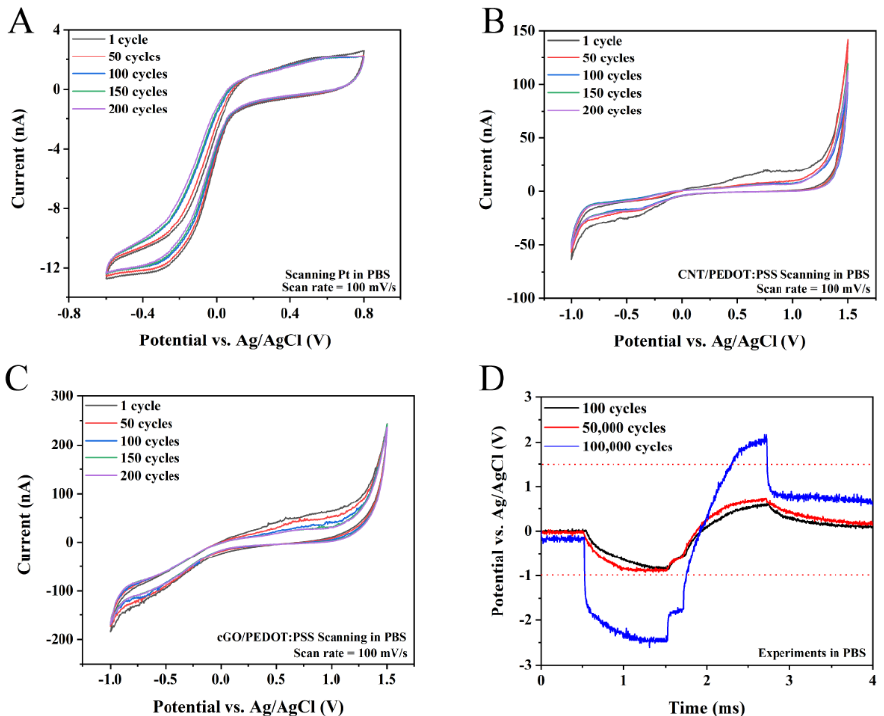
Figure 4. Stability of the interface. ( A ) The CV scanning curve of the Pt-based interface after the 1st, 50th, 100th, and 200th scan cycles. ( B ) The CV scanning curve of the CNT/PEDOT:PSS-modified interface after the 1st, 50th, 100th, and 200th scan cycles. ( C ) The CV scanning curve of the cGO/PEDOT:PSS-modified interface after the 1st, 50th, 100th, and 200th scan cycles. ( D ) The stability of the interface (cGO/PEDOT:PSS) under long-term